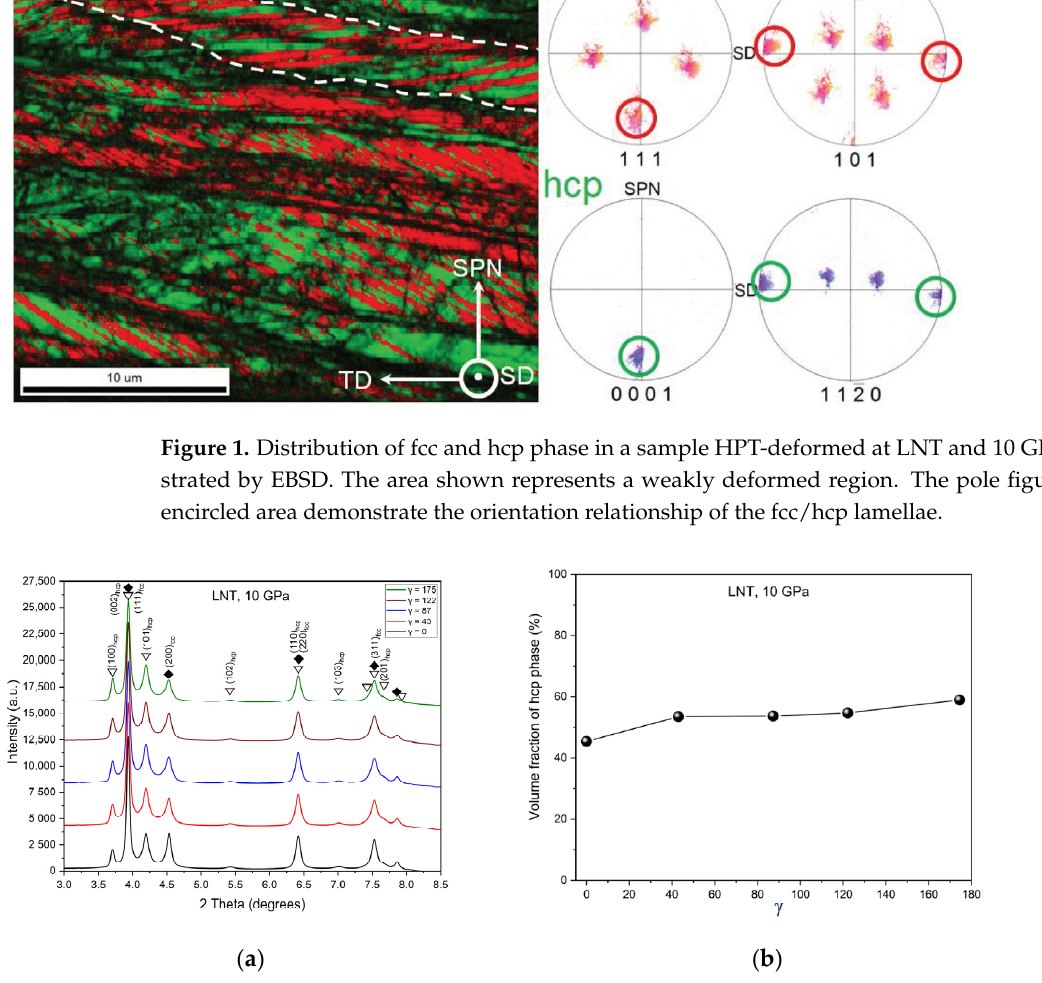
Figure 4. Volume fraction of martensitic phase versus pressure at a shear strain γ ≈ 100. The sym- bols represent different series of HPT samples, for which the phase composition was measured af- ter the number of months indicated.